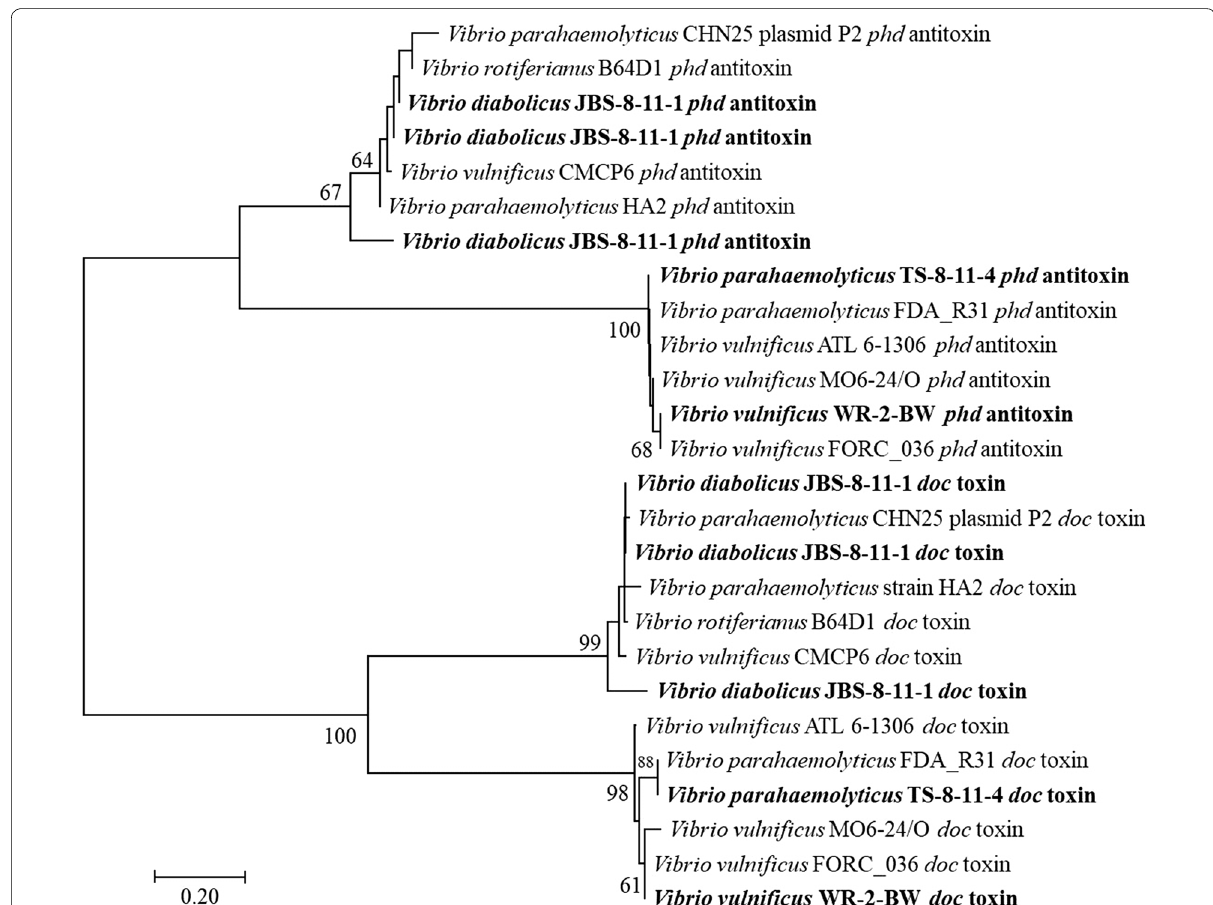
Fig. 2 Maximum-likelihood phylogeny (Kimura 2-parameter model) of doc toxin genes and phd antitoxin genes. Bold indicates sequences obtained from this study. The bootstrap values represent 1000 replications, and values of less than 50 are not shown. The reference sequences were acquired from NCBI